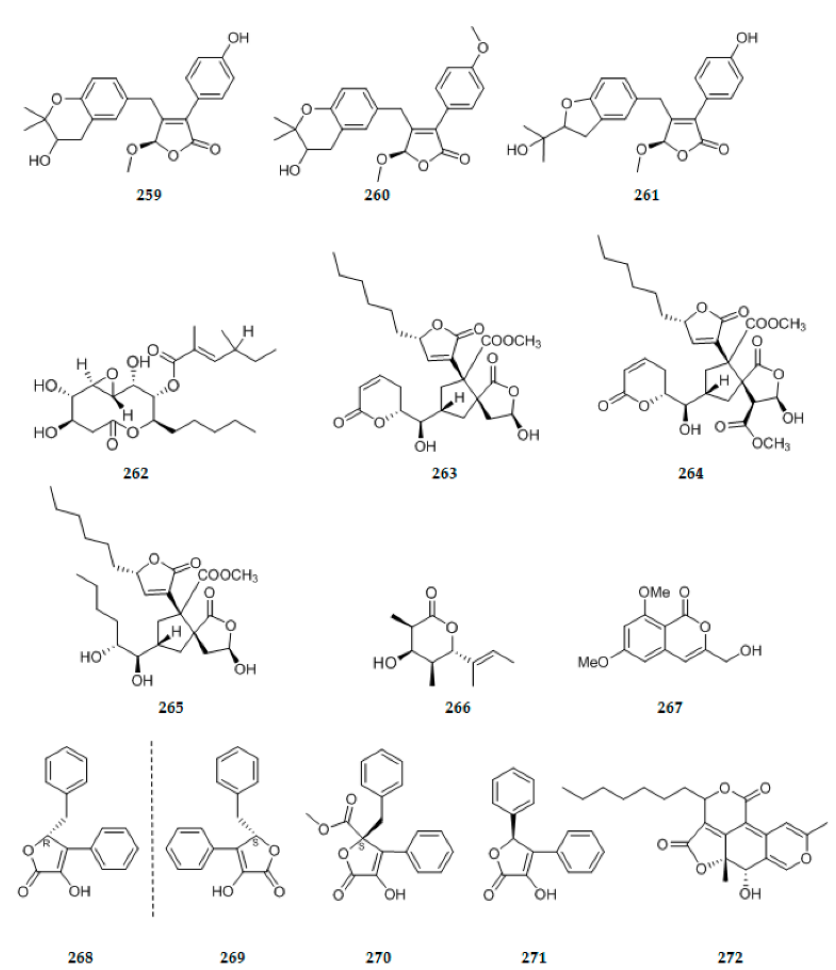
Figure 9. Chemical structures of lactones.